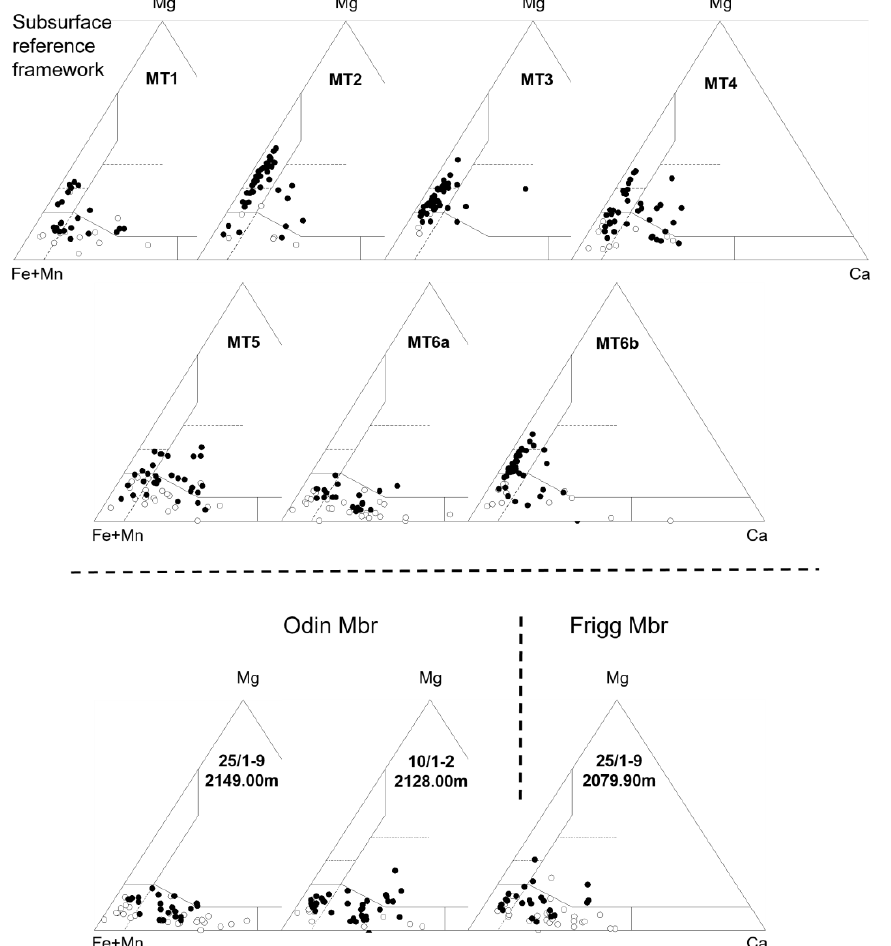
Figure 10. Evolution in Palaeocene-Early Eocene garnet provenance in UK Quadrant 9 and adjacent areas in the Norwegian sector of the North Sea, from Morton et al. (1993). Unit MT1 = Norwegian well 26/4-1, 2253.0 m; Unit MT2 = UK Well 9/12-2, 2465.9 m; Unit MT3 = UK Well 9/13-1, 2252.5 m; Unit MT4 = UK Well 9/13-1, 2130.3 m; Unit MT5 = UK Well 9/23-1, 1905.0 m; Unit MT6a = Norwegian Well 25/10-1, 1786.8 m; Unit MT6b = Norwegian Well 16/1-1, 2347.0 m. Also shown are garnet as-